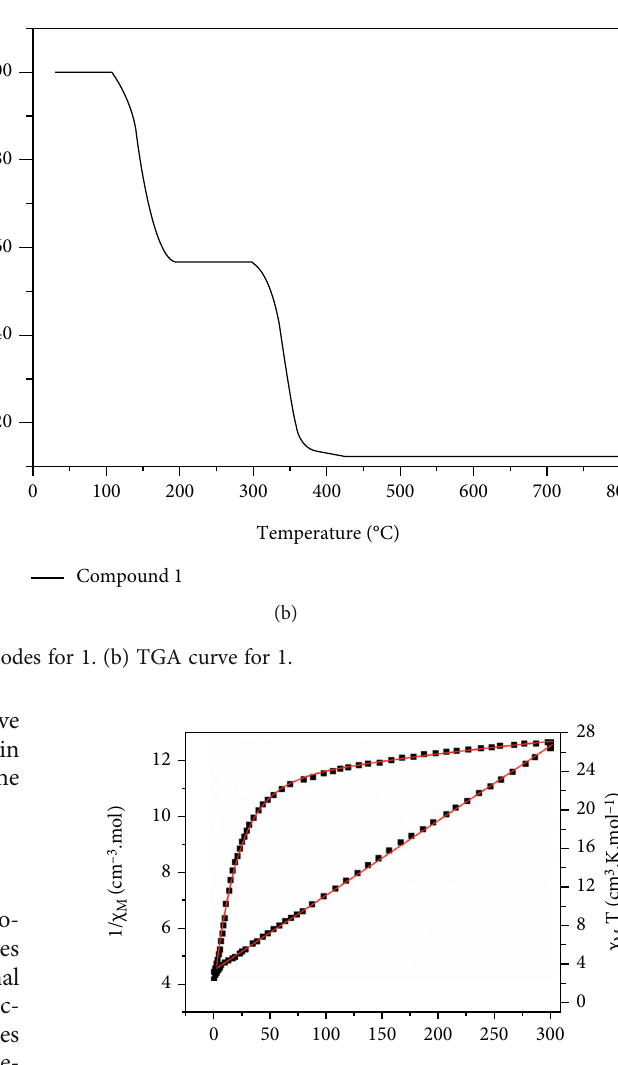
Figure 3: Temperature dependence of χ thousand